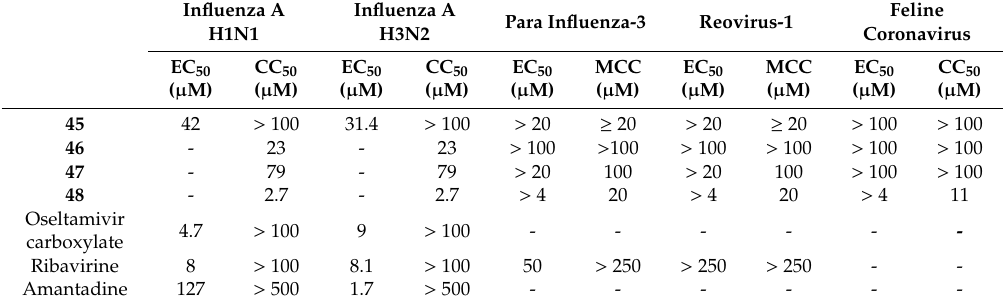
in vitro antiviral assay showed